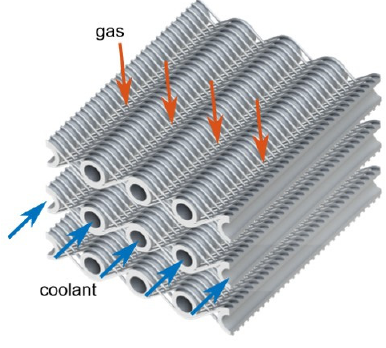
Figure 1. Illustration of a woven cloth micro heat exchanger featuring a wire-screen / tubing structure, with coolant flow through tubes in blue and cross-flow of gas through the wire-screen in red.